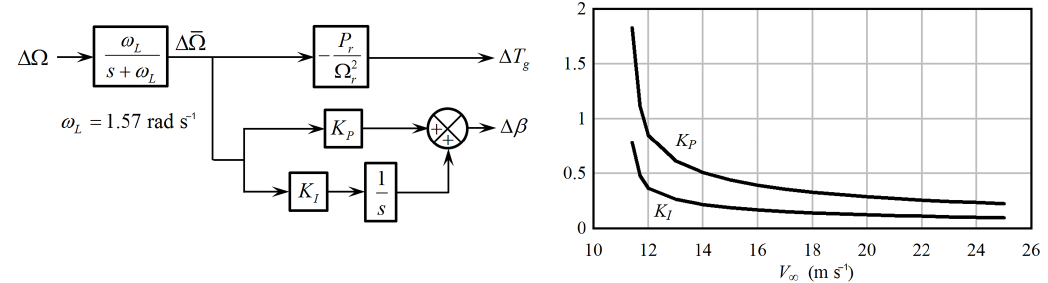
Figure 1. The effective above-rated blade pitch and generator torque controller of the NREL 5 MW wind turbine, for small perturbations about a mean operating